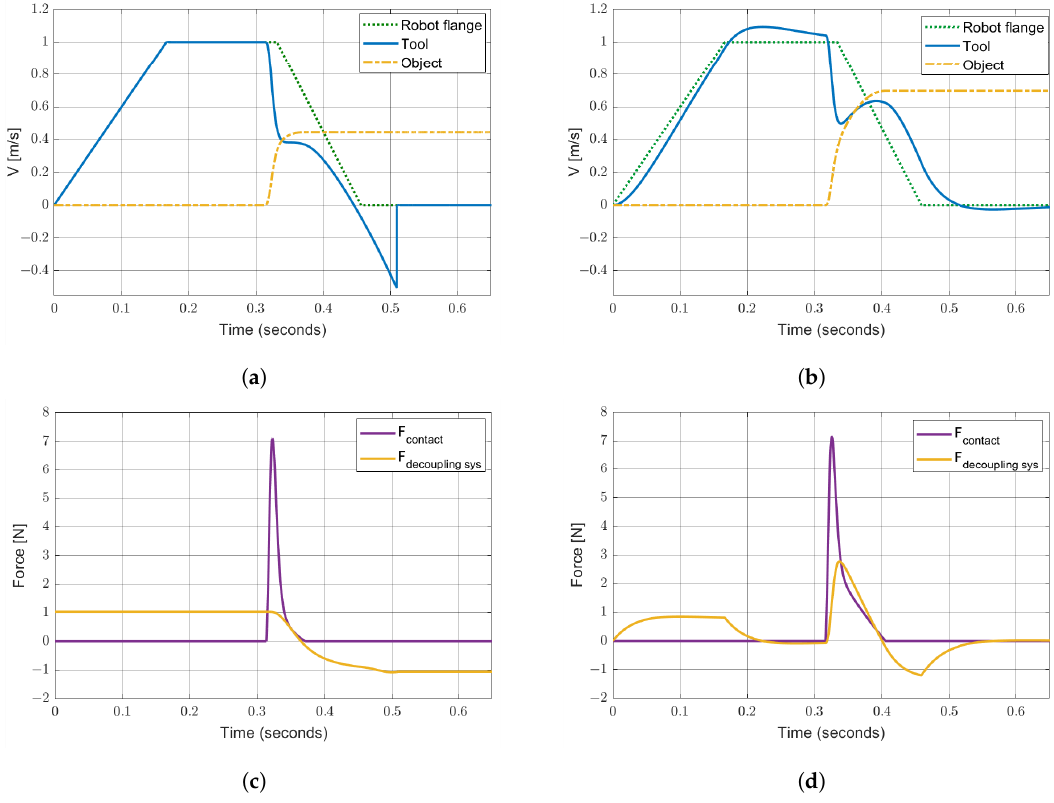
Figure 23. Velocity comparison: ( a ) end-effector with bi-stable mechanism; ( b ) end-effector with a linear spring–damper system. Contact force and total force generated by the end-effector: ( c ) bi-stable mechanism; ( d ) linear spring–damper. ( e =